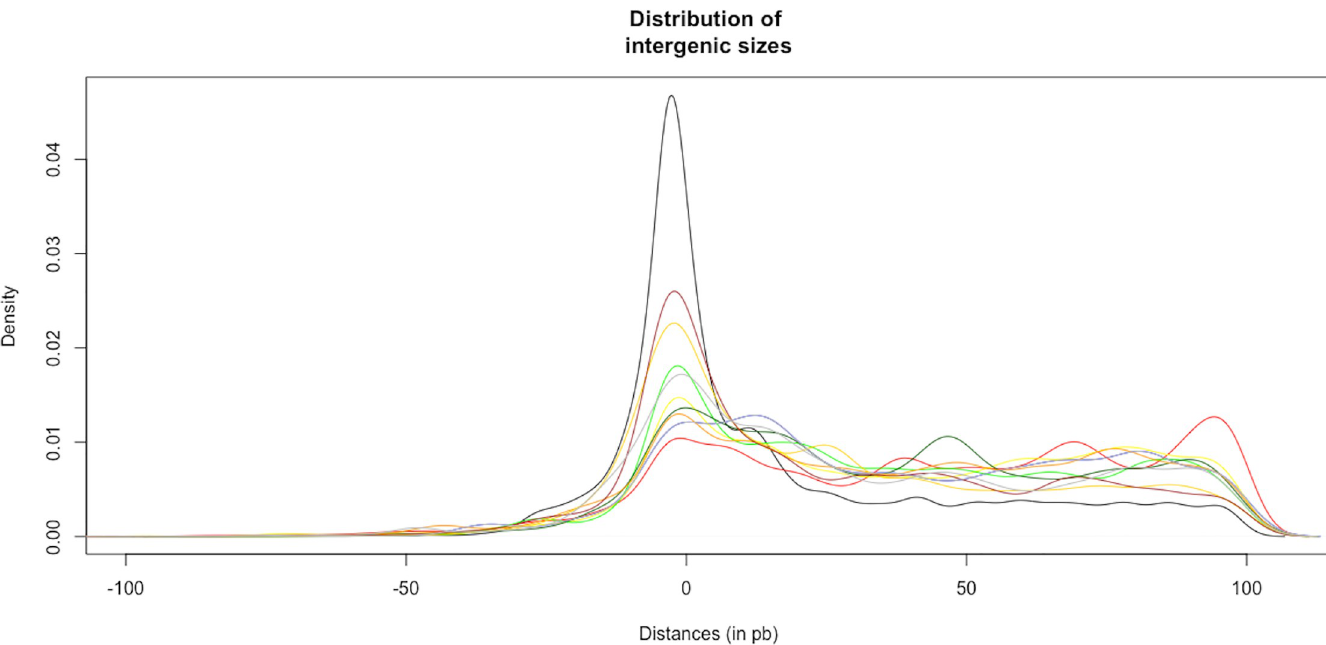
Fig 3. Distributions of intergenic regions of the divergent genes and regulators. The x axis shows length between the TFs and their divergent genes (in base pairs). Colors represent each TF family. PF00356, GalR/LacI (blue); PF00126, LysR (red); PF00440, TetR/ AcrR (yellow); PF00392, GntR (green); PF01047, MarR (darkgreen); PF12833, HTH_18 (orange); PF02954, Fis (gold); PF00196, LuxR/UhpA (brown); PF01381, HTH_3 (grey); PF00486, OmpR/PhoB(pink).